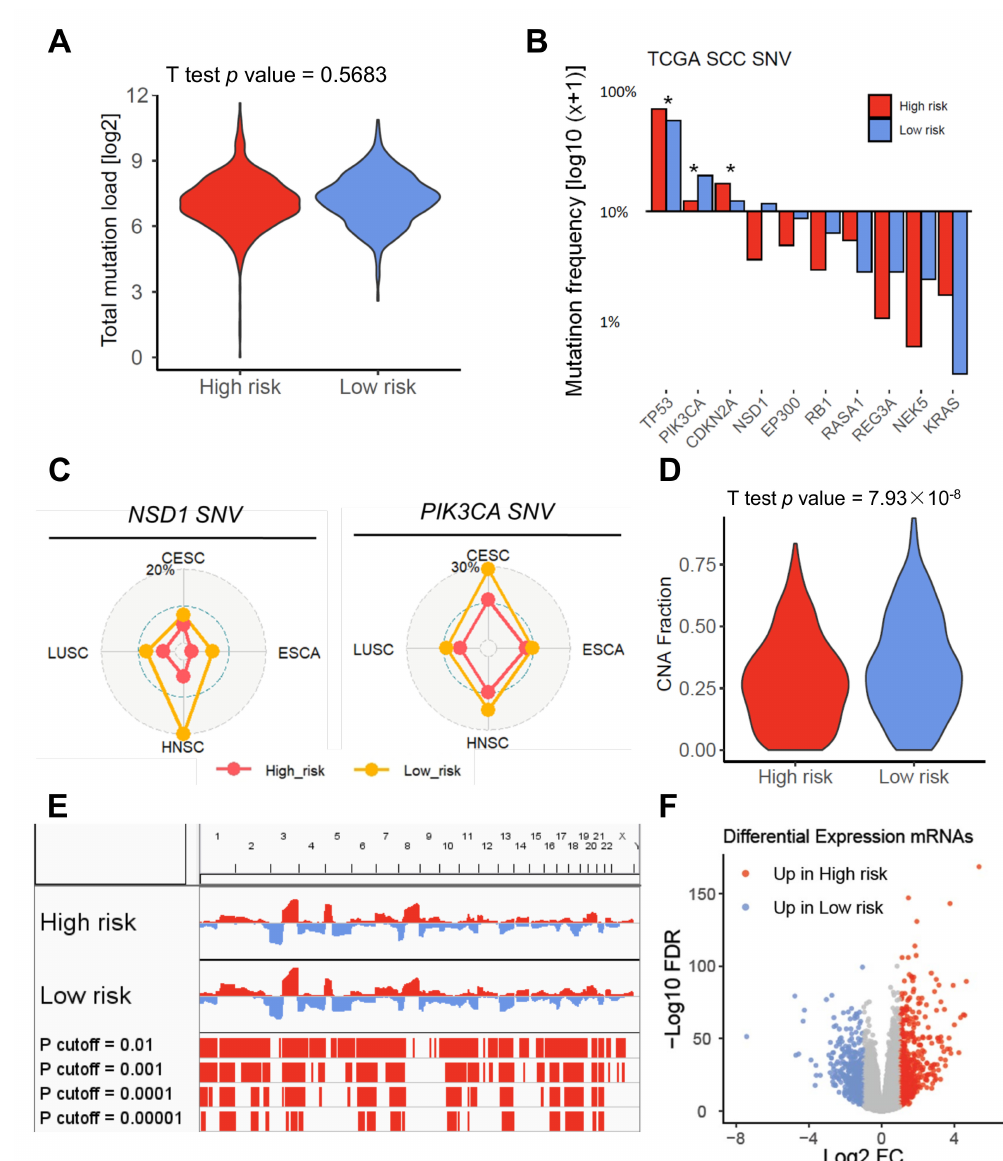
Figure 3. Differences in the mutational landscape among high-risk and low-risk subgroups of the pan-SCC cohort. ( A ) Violin plot demonstrates no significant difference for total mutation load among high-risk and low-risk subgroups of the pan-SCC cohort. ( B ) Bar plot summarizes the relative abundance of somatic mutations for significant MutSig genes (chi-square test p < 0.05) among high-risk and low-risk subgroups of the pan-SCC cohort. * chi-square test p < 0.001. ( C ) Graphs show the relative frequency of either NSD1 (left) or PIK3CA (right) somatic mutations for the indicated TCGA cohorts. ( D ) Violin plot demonstrates a significant higher global CNA fraction in the low-risk as compared to high-risk subgroup for the pan-SCC cohort. ( E ) CNA plot shows the relative frequency of copy number gains (red) or deletions (blue) among high-risk and low-risk subgroups of the pan-SCC cohort and displays highly significant differences by Fisher’s exact test. ( F ) Volcano plot presents significant differentially expressed genes (DEGs) ( − 1 > log 2 FC > 1, FDR < 0.05, n = 1081) among high-risk and low-risk subgroups of the pan-SCC cohort computed by